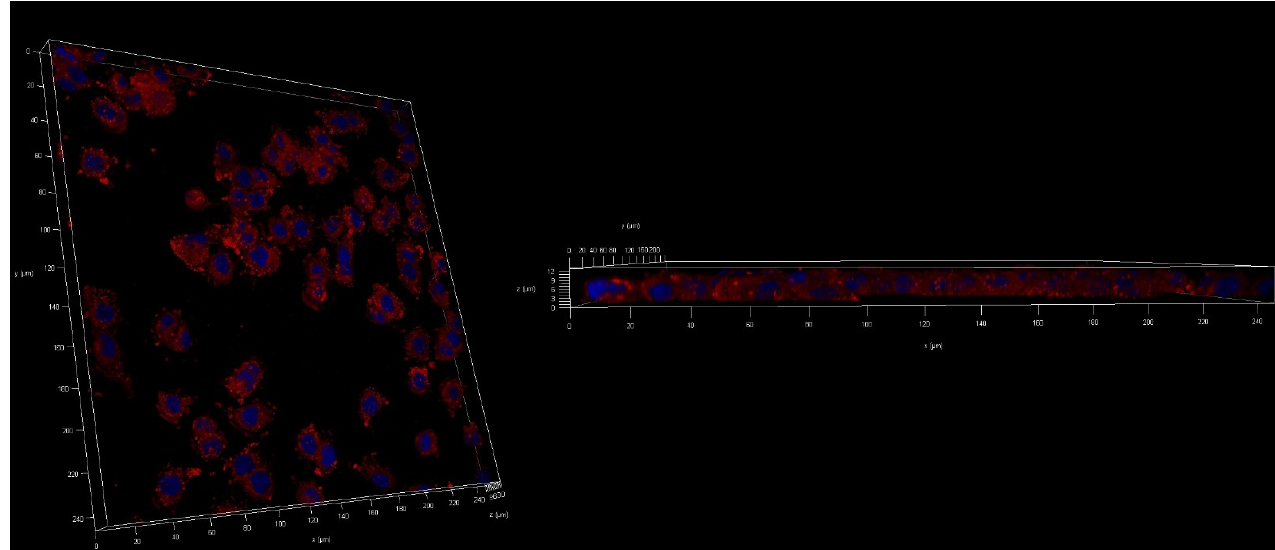
Figure 16. Z-stack analysis of the cellular uptake of Nile-Red-loaded UA-S85-PLGA-PEG 2000 nanoparticles by AsPC-1 pancreatic cell lines.